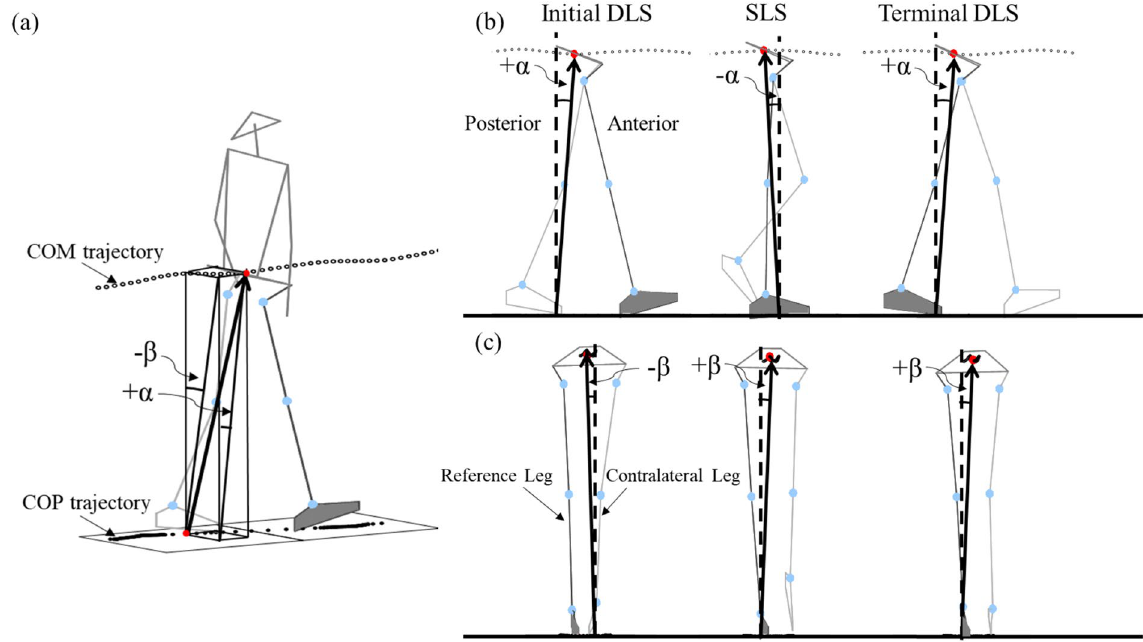
Figure 1. ( a ) Stick figure of the typical subject during level walking showing three-dimensional trajectories of the COM and COP, and the COM–COP vector forming sagittal inclination angles (α) and frontal inclination angles (β) with the vertical. The COM–COP vector and the inclination angles in the sagittal ( b ) and frontal ( c ) planes during initial and terminal double-limb support (DLS), and single-limb support (SLS) are also shown. The reference limb is shown in darker